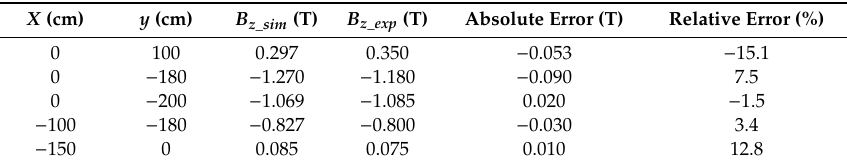
Table 2. Absolute and relative errors of the SMF model for some representative